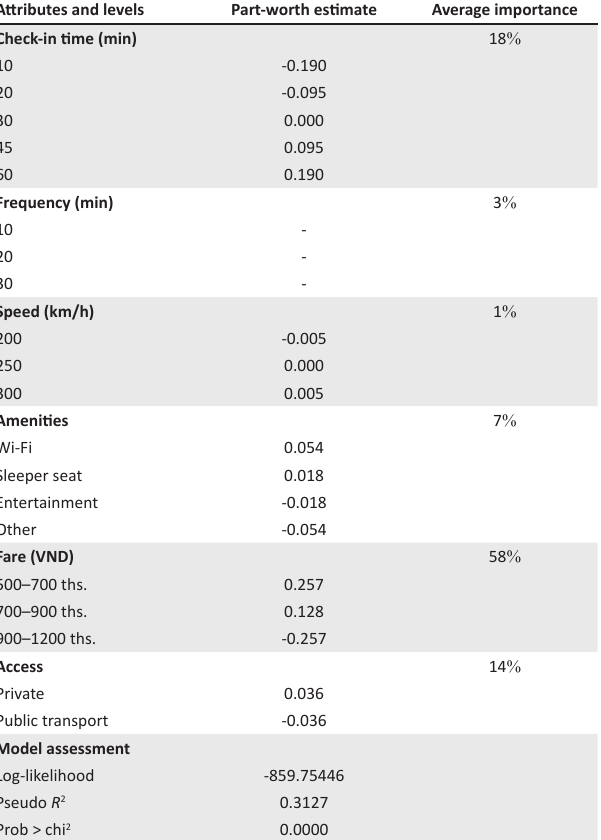
TABLE 4: Model summary statistics. Attributes and levels